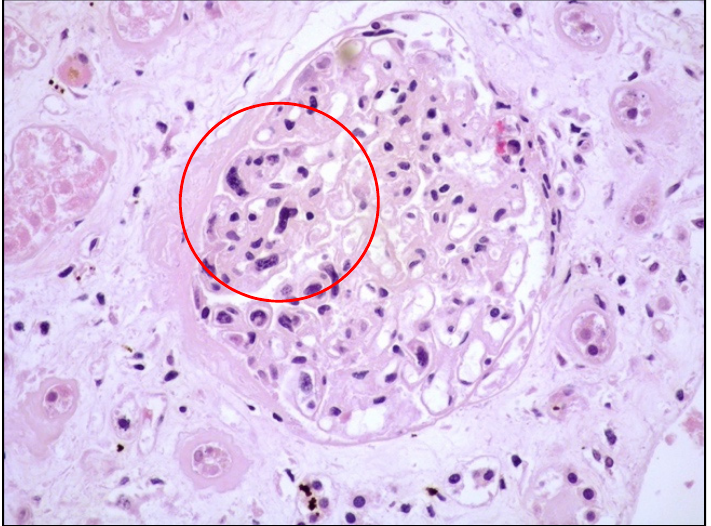
Figure 1. High-power view showing kidney parenchyma with large, atypical cells growing within vascular spaces (see within red circle; hematoxylin and eosin, 200× magnification, previously unpublished, original image from S.A.).